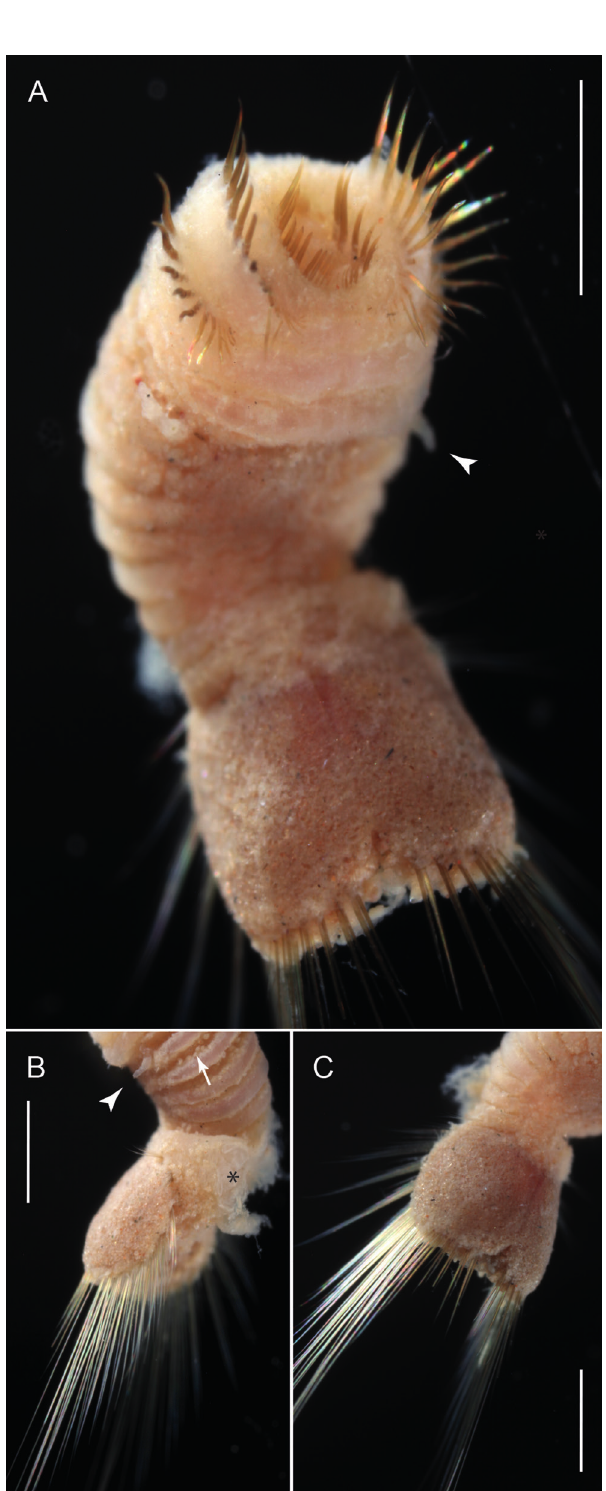
Fig. 4. Mauretanaspis longichaeta gen. et spec. nov., paratype (SMF 27777). A . Entire specimen, ventral view. B . Pre-shield and abdominal region, ventrolateral view. C . Abdominal region, showing arrangement of lateral and posterior shield chaetae, ventral view. Arrowheads = gonopodial lobes; arrow = body papillae; * = body damage on dorsal side. Scale bars: 1